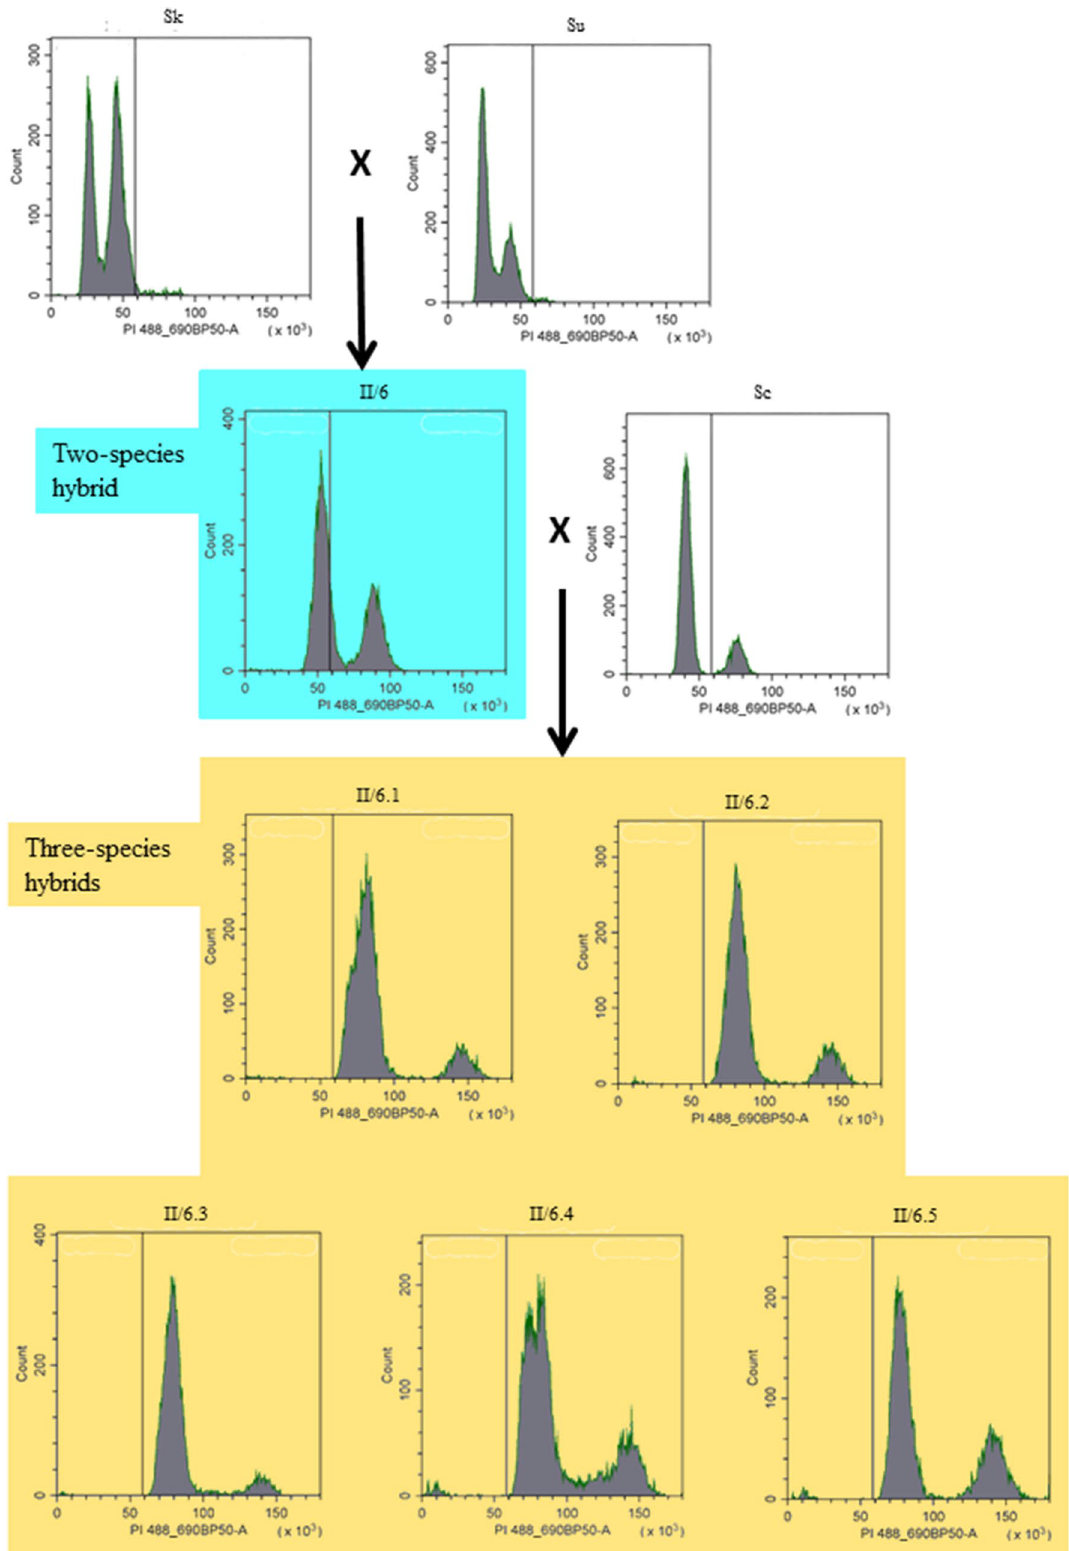
Figure 1. DNA content of strains measured by propidium-iodide staining and flow cytometry